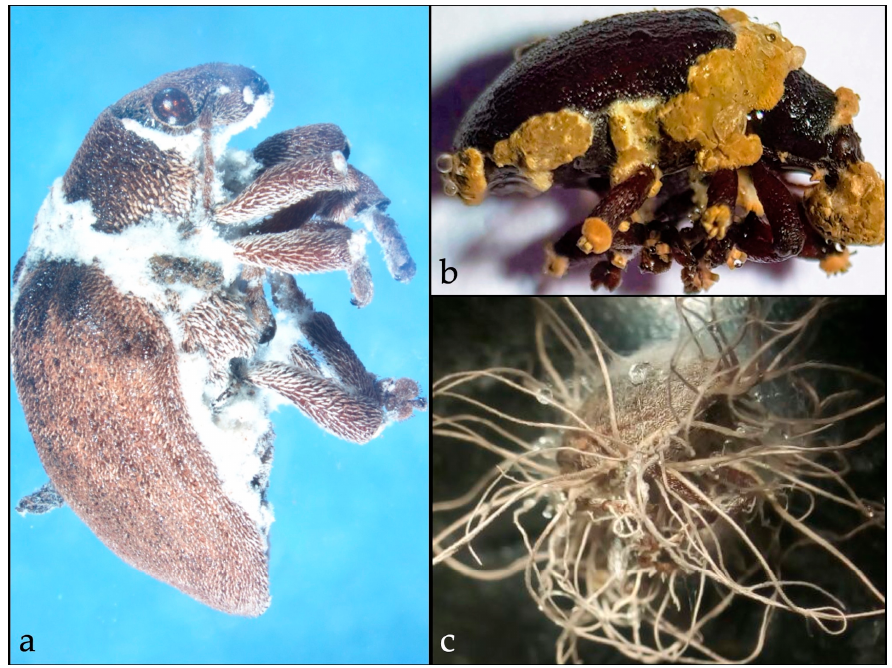
Figure 2. Entomopathogenic fungi on Gonipterus platensis infected by. ( a ) . Beauveria sp. ( b ) . Hirsutella sp., and ( c ) . Metarhizium sp.